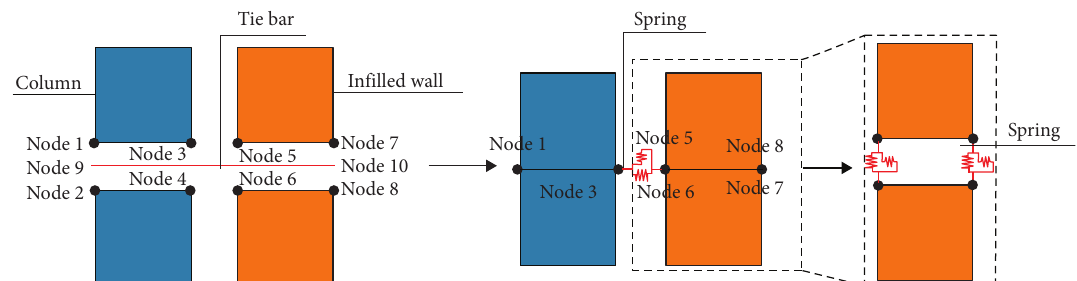
Figure 15: Schematic diagram of the relationship between infilled wall and frame column (beam).